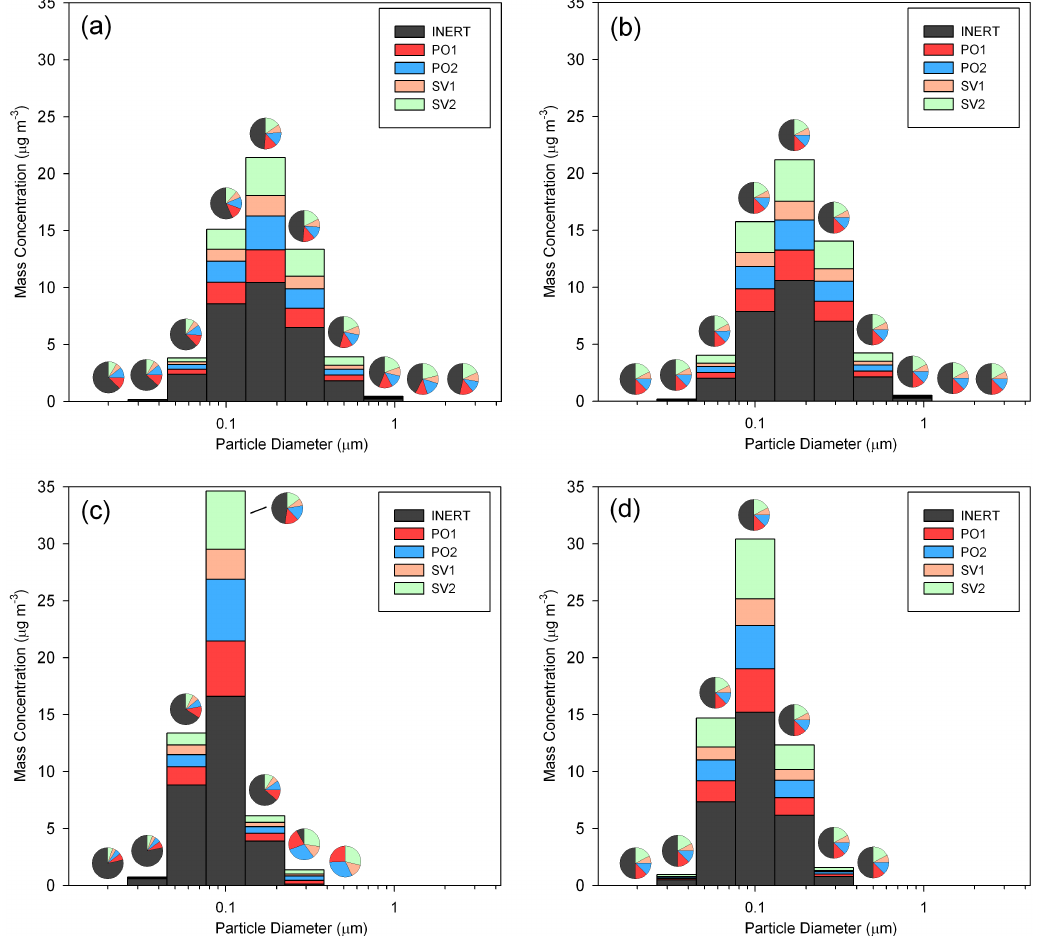
Fig. 3. Size and component distributions at t =188 h for base case scenario simulations. (a) external mixture with coagulation, (b) internal mixture with coagulation, (c) external mixture without coagulation, (d) internal mixture without coagulation.